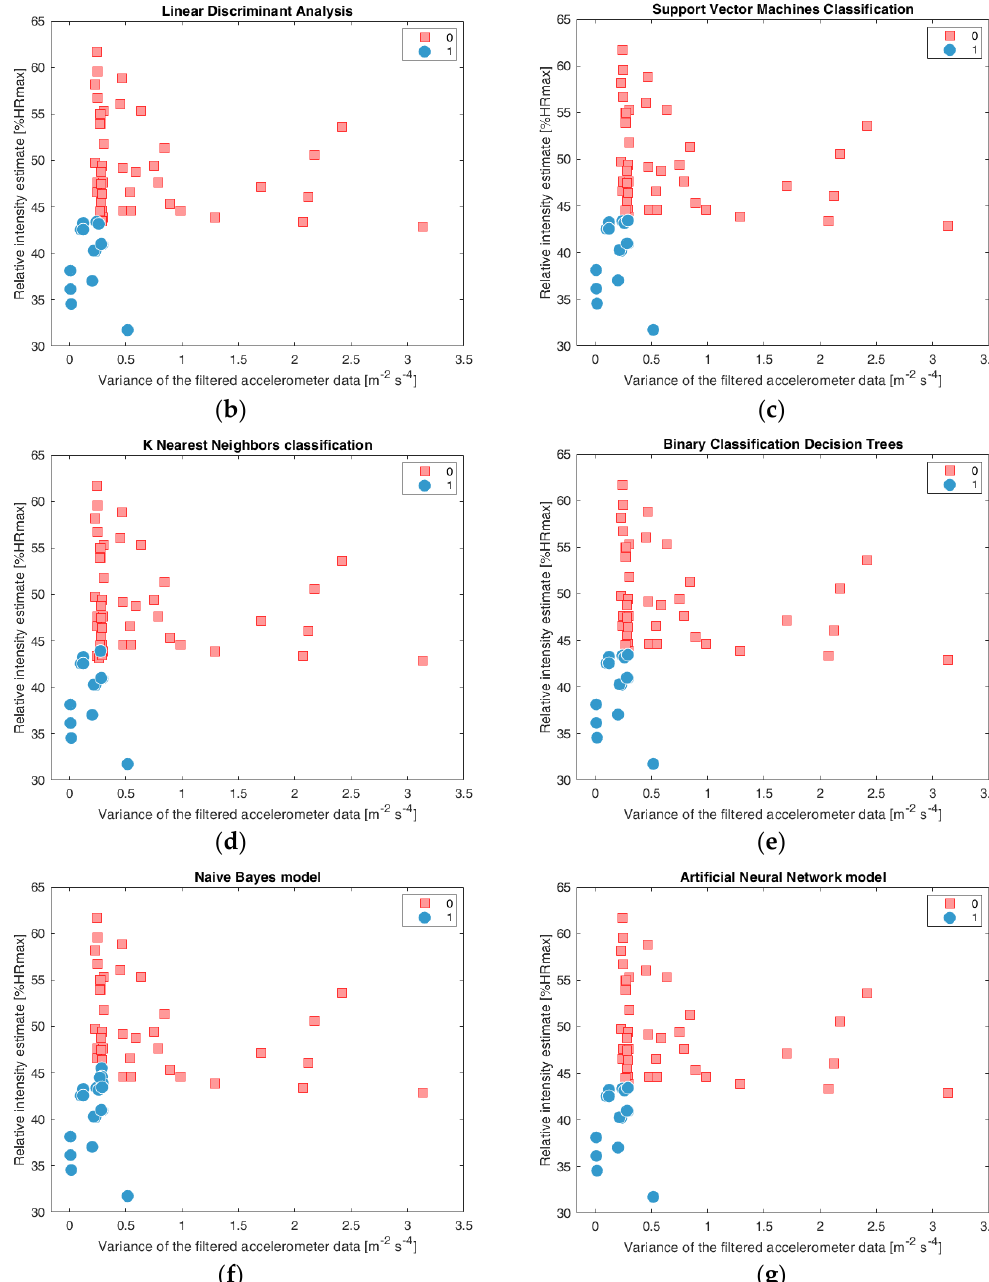
Figure 6. The diagram of transformation of wearable sensor signal into feature space by a machine learning approach: two-dimensional scatter-plots (labeled data) ( a ), Linear Discriminant Analysis ( b ), Support Vector Machines ( c ), K Nearest Neighbors ( d ), Binary Decision Trees ( e ), Naive Bayes ( f ), Artificial Neural Network ( g ). Table 1. The assessment of the proposed method.